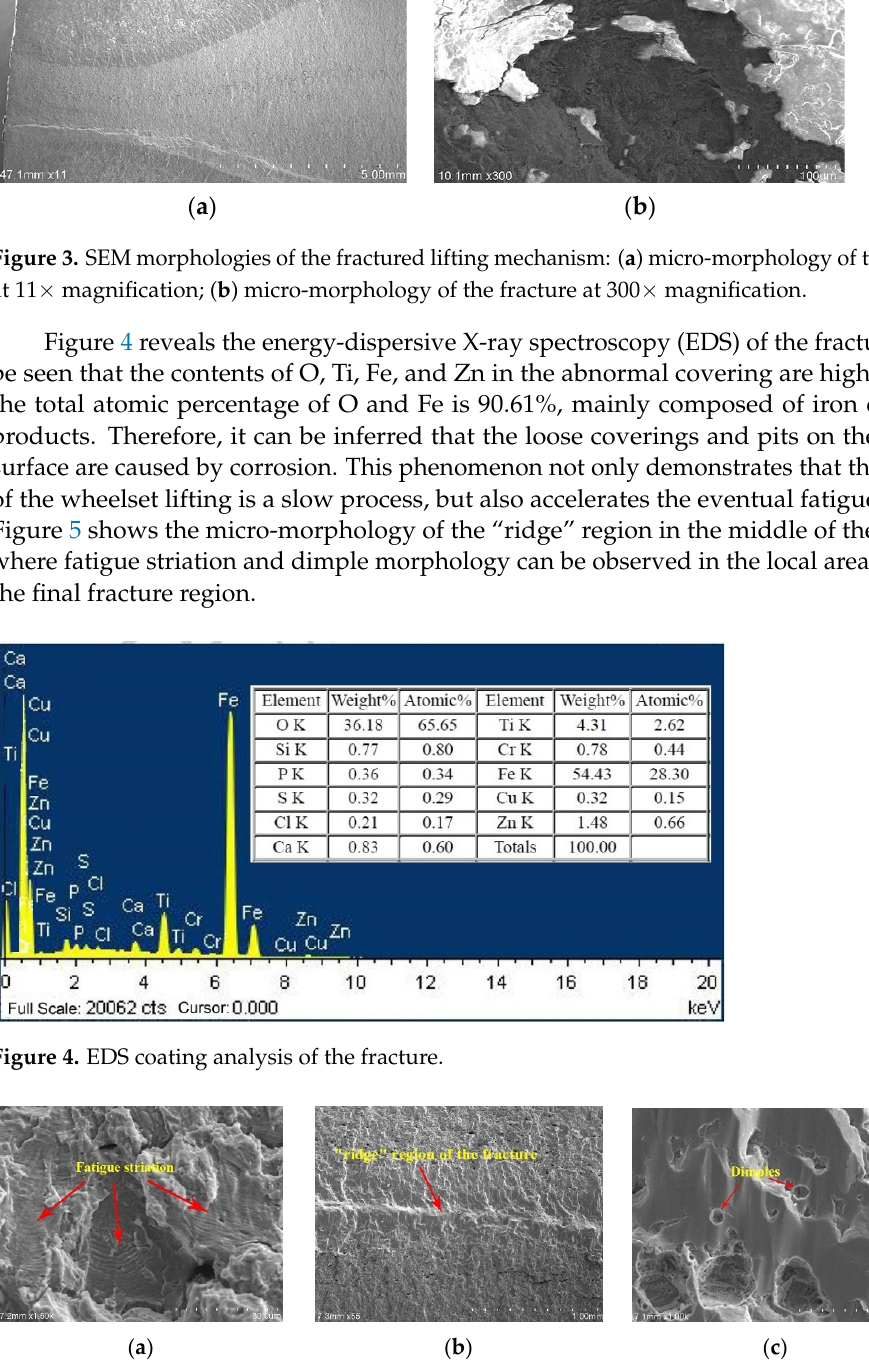
Figure 5. Micro-morphology of the “ridge” region of the fractured lifting mechanism: ( a ) micro-morphology of a stepped stripe at 1500× magnification; ( b ) micro-morphology of the “ridge” region at 55× magnification; ( c ) micro-morphology of the “ridge” region at 1000× magnification.